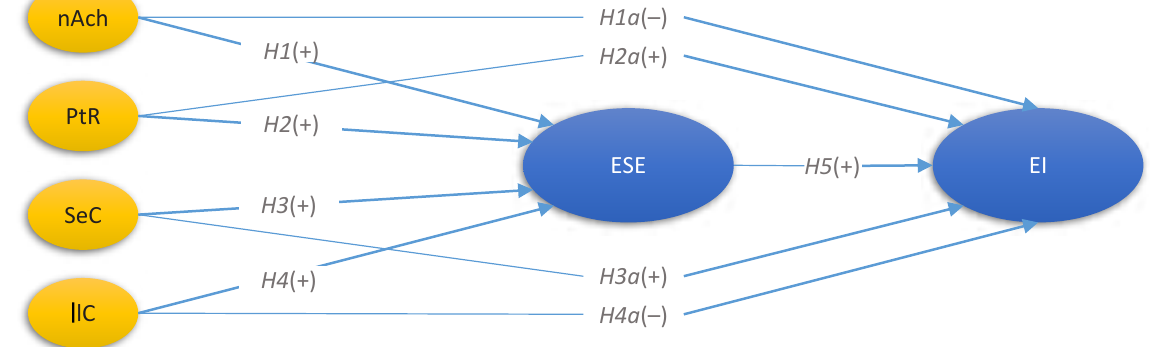
Figure 1. Entrepreneurial self-efficacy (ESE) hypothesized